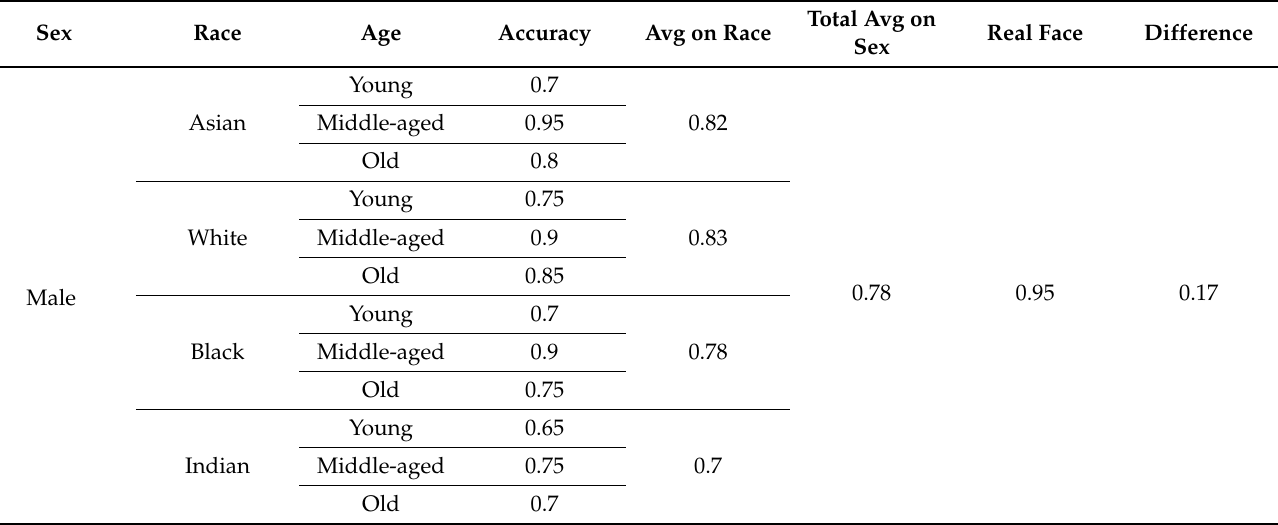
Table 2. Accuracy of a facial recognition model on sex recognition for generated and real